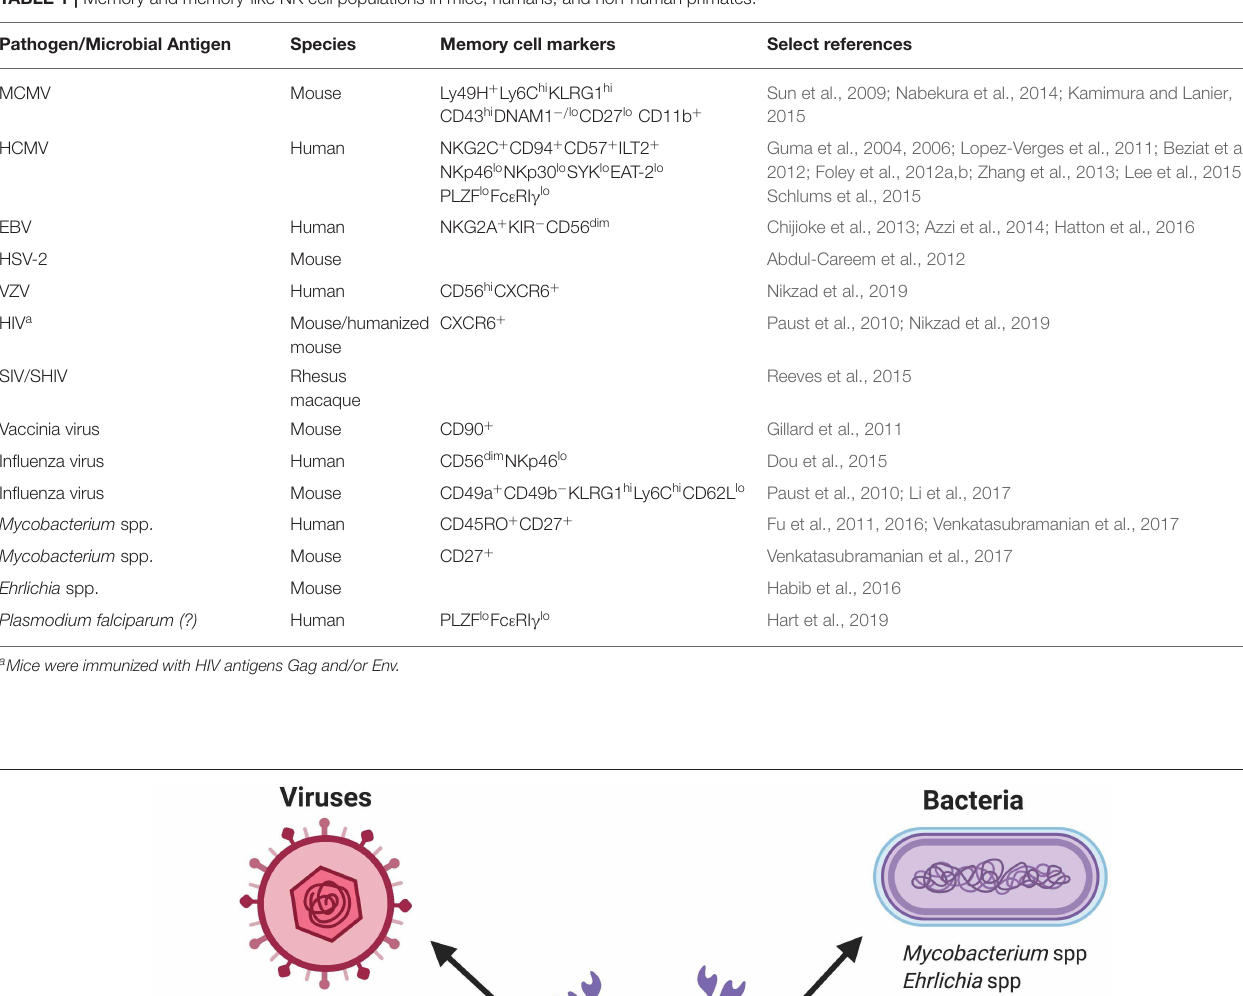
TABLE 1 | Memory and memory-like NK cell populations in mice, humans, and non-human primates.